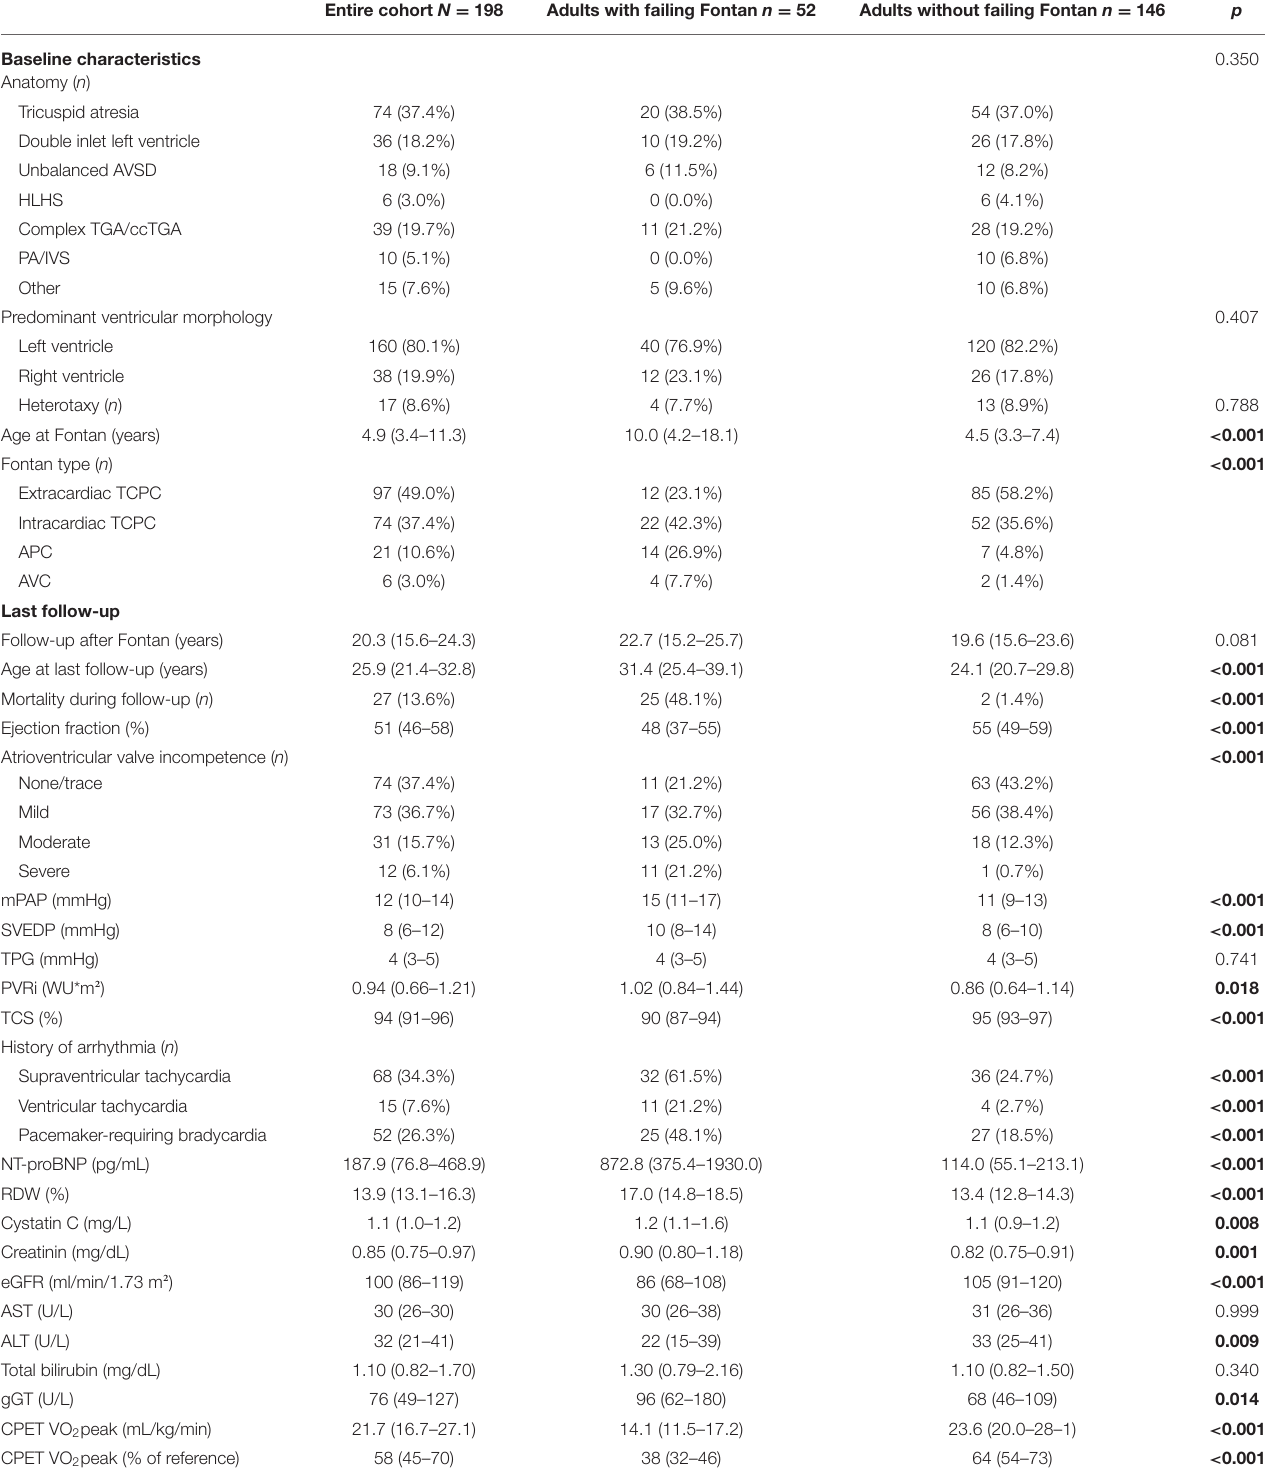
Entire cohort N =